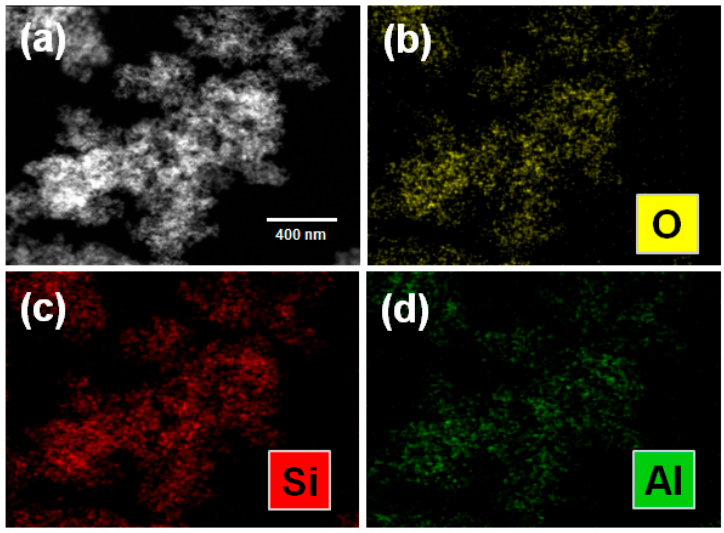
Figure 5. ( a ) FE-TEM image of the silica-alumina nanoparticles; and the corresponding: ( b ) O; ( c ) Si; and ( d ) Al EDX maps.